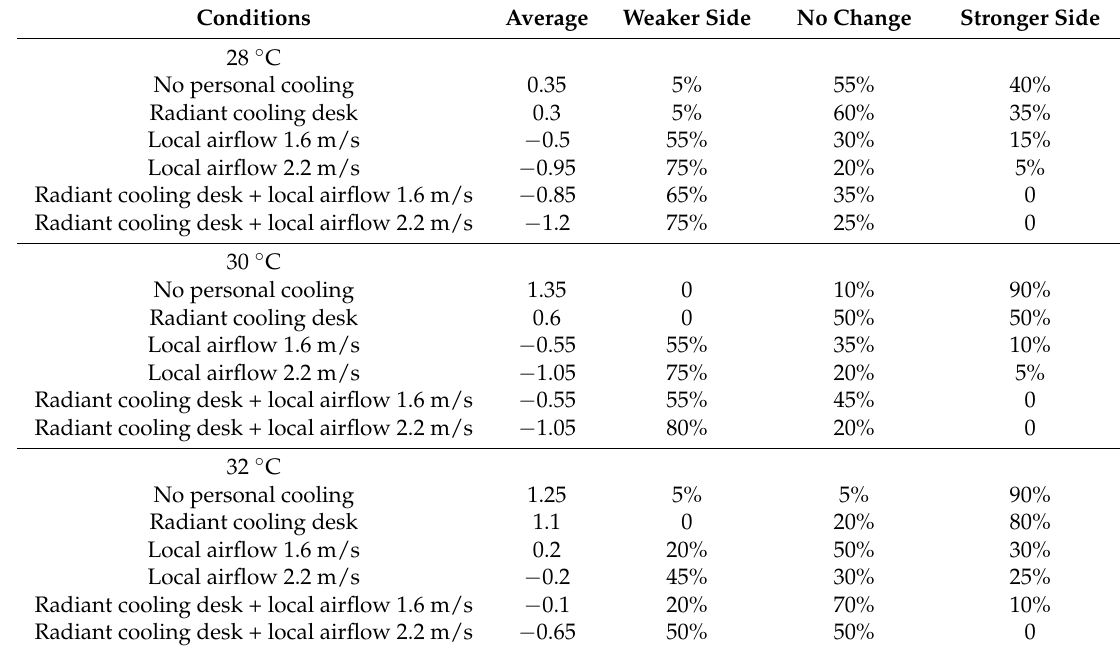
Table 8. Air movement preference in the final